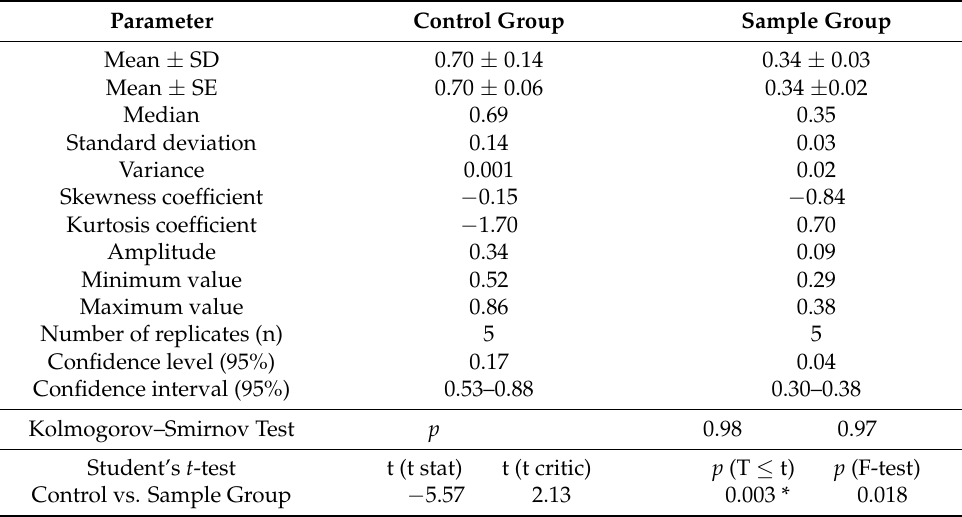
Table 2. Data processing of triiodothyronine values (T3 as